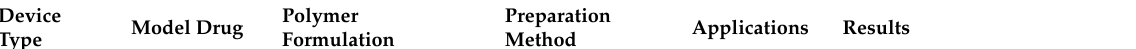
Table 3. Recent investigations on PNIPAM-based hydrogels for tissue